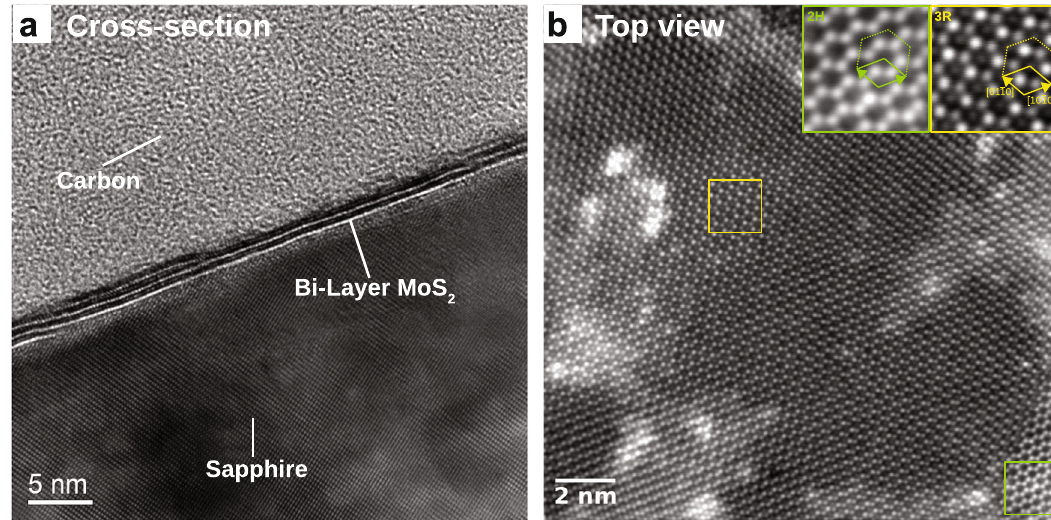
Fig. 4 TEM images of the ALD MoS2 fi lm. a Cross-sectional view by conventional TEM and b top view HAADF-STEM image (noise fi ltered), the insets show magni fi cations of regions with 3R stacking (yellow) and 2H stacking (green) along the [0001] zone axis.